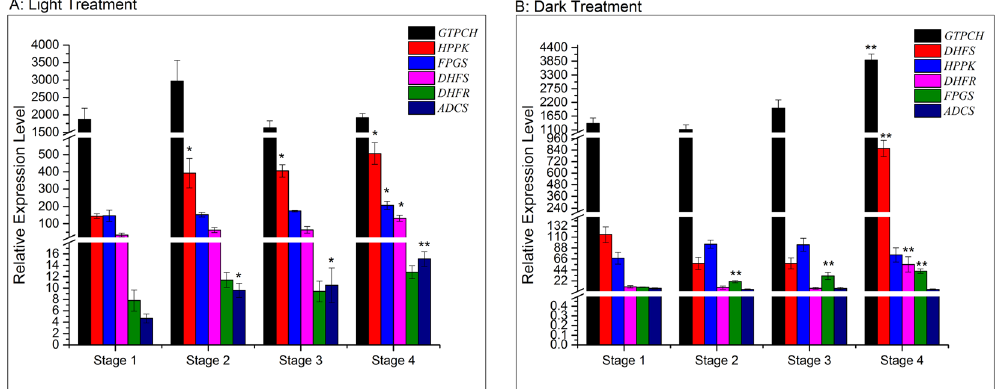
Figure 7. Changes of relative expression level of relevant genes in folate biosynthetic pathway during sweet corn seed germination; Bars with * and ** indicates significant difference at p < 0.05 and p < 0.01 respectively compared to stage 1. ( a ) Light treatment; ( b ) dark